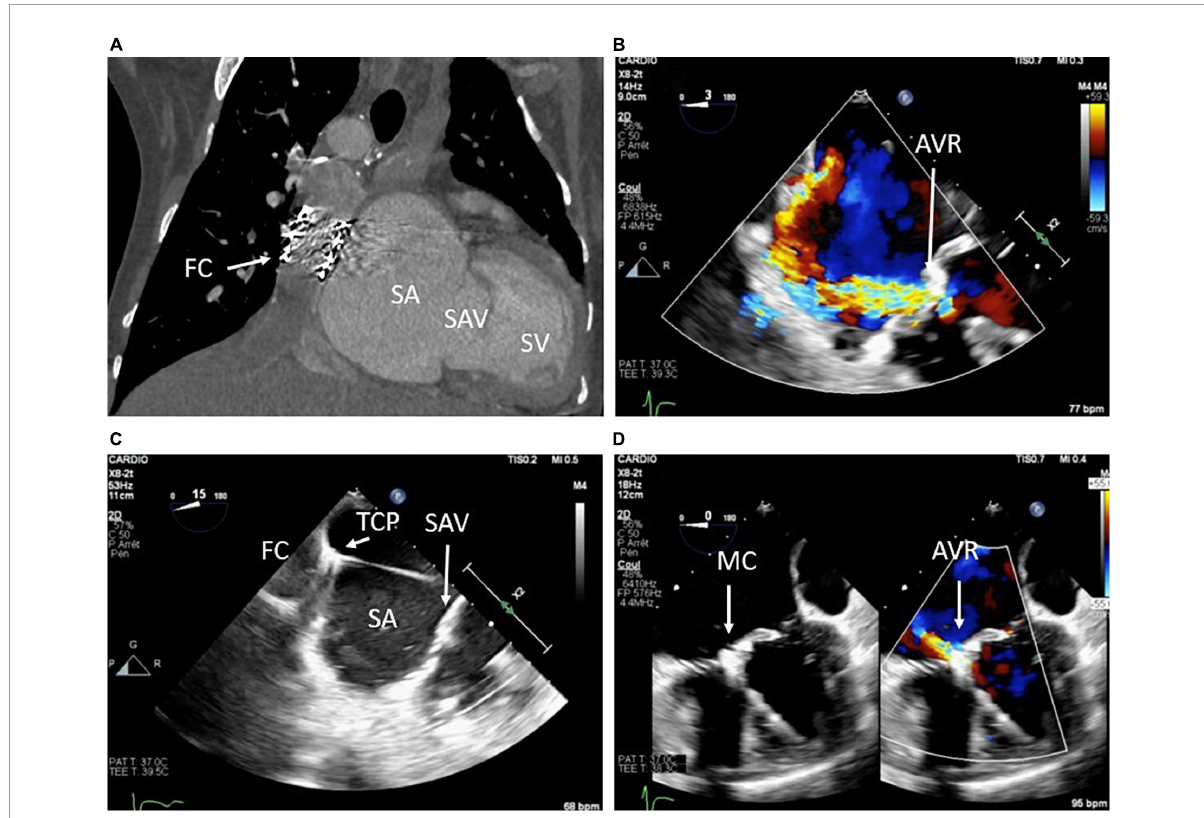
FIGURE10 Percutaneous atrioventricular valve edge-to-edge repair procedure in a patient with Fontan Circulation. (A) Computed tomography scanner showing the Fontan conduct (FC) connecting the inferior vena cava to the pulmonary artery, the single atrium (SA), the single atrioventricular valve (SAV), and the single ventricle (SV); (B) transesophageal echography with color Doppler showing the high-grade regurgitation of the atrioventricular valve (AVR); (C) echo guided puncture of the Fontan conduct connecting the inferior vena cava and the left pulmonary artery; (D) result after Mitra-clip (MC) implantation responsible for a dramatic decrease of the